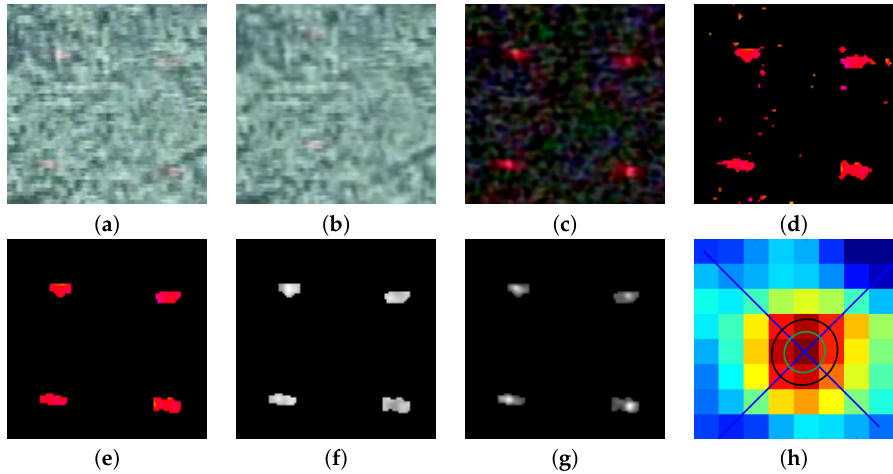
Figure 8. Laser spot detection: ( a ) predicted ROI of original image, ( b ) aligned auxiliary patch, ( c ) ROI after the removal of texture information (intensity × 5), ( d ) potential laser pixels after color thresholding, ( e ) filtered laser pixels, ( f , g ) estimated laser beam luminosity without/with texture removal, and ( h ) detected laser spot with detection